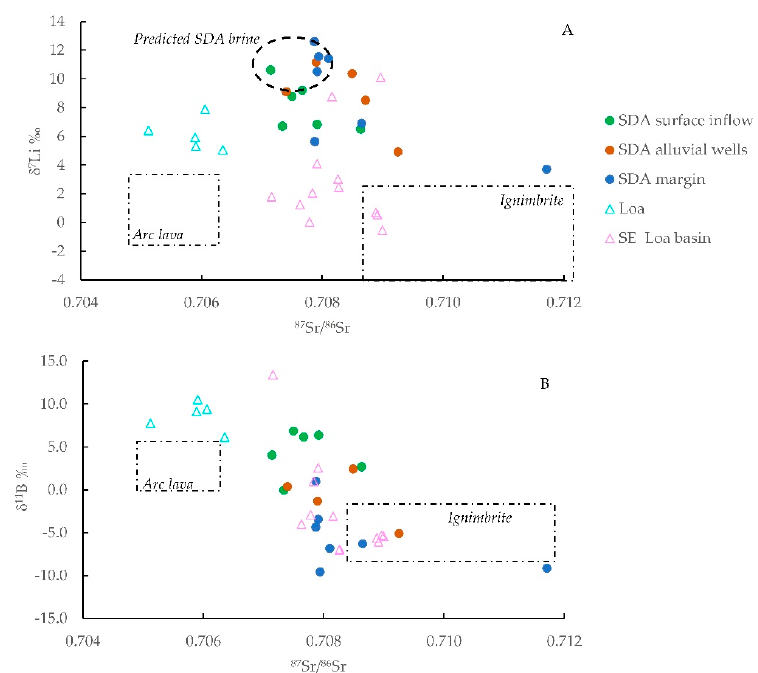
Figure 3. Diagrams showing the relationship between lithology, as indicated by 87 Sr / 86 Sr and ( A ) Li and ( B ) isotopes. Ignimbrite and arc lava fields are from References [7,13,47,48]. Data for water in the neighboring upper Loa drainage basin is from [13], virtually the same. Ignimbrite and arc lava fields are from References [7,13,47,48].